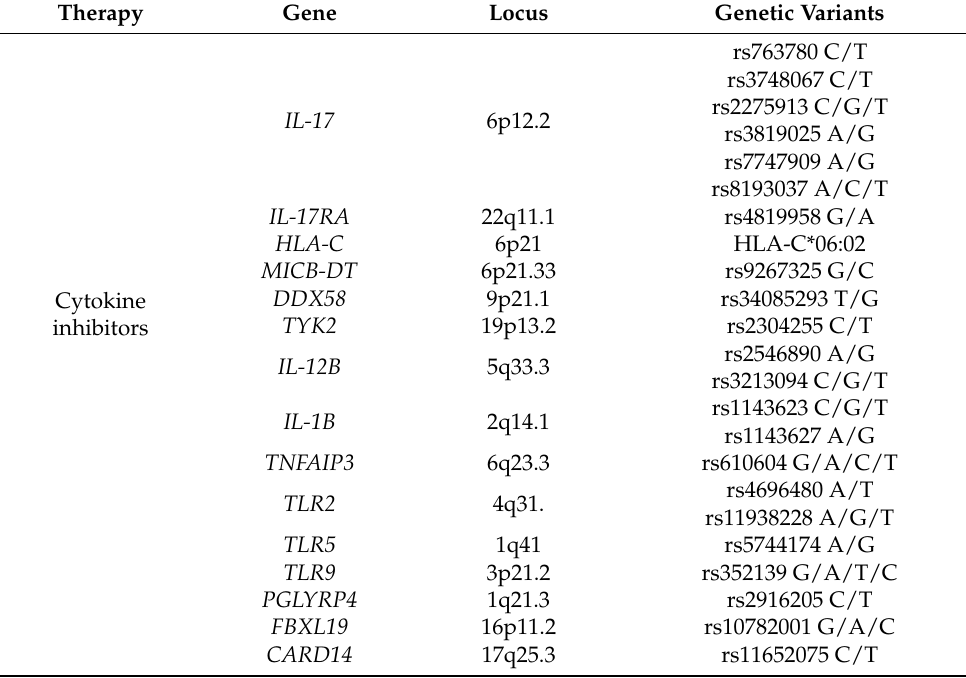
Table 2. Genes and genetic variants potentially involved in the response to cytokine inhibitors.